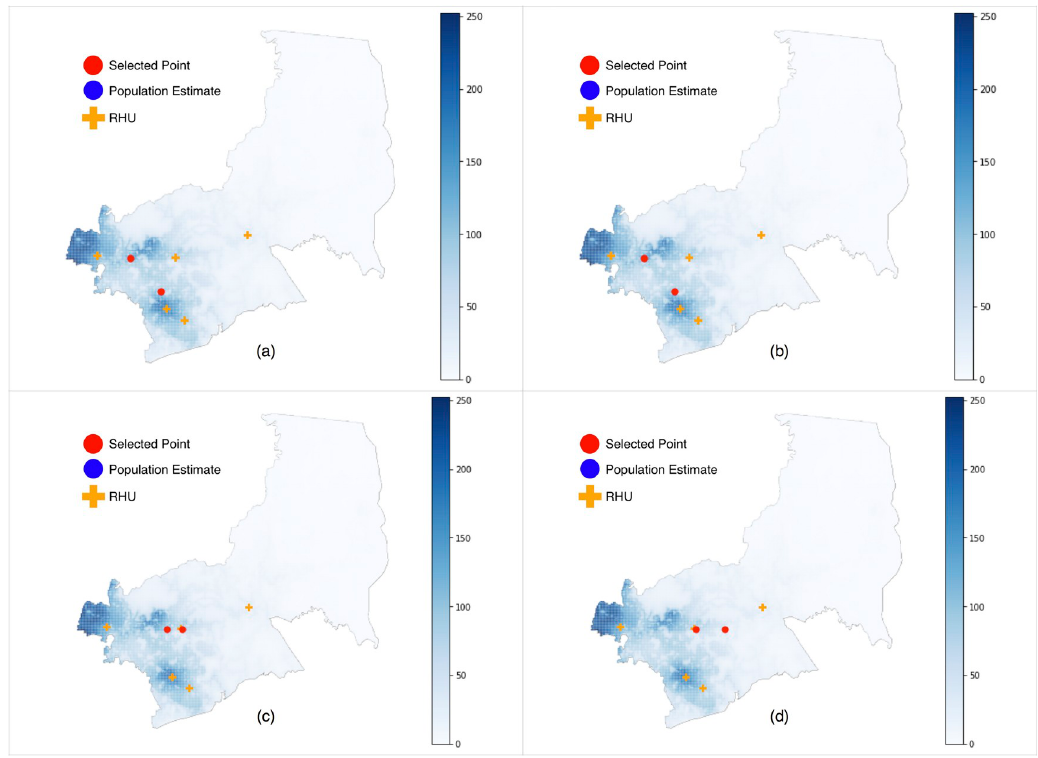
Fig 4. Simulations with modified distance decay formula parameters. (a) θ = 6.29 minutes, (b) θ = 45.0 minutes, (c) θ = 60.0 minutes, (d) θ = 120.0 minutes, All simulations run with no demand readjustment, B = 20, μ = 0.20, α = 0.66, σ = 0.40, β = 2.14, as estimated by [23].